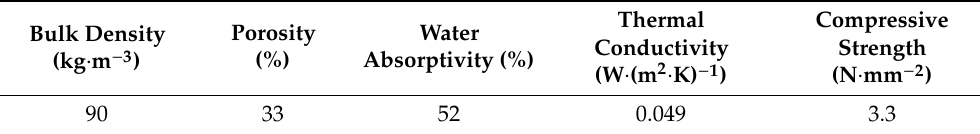
Table 3. Physical properties of expanded